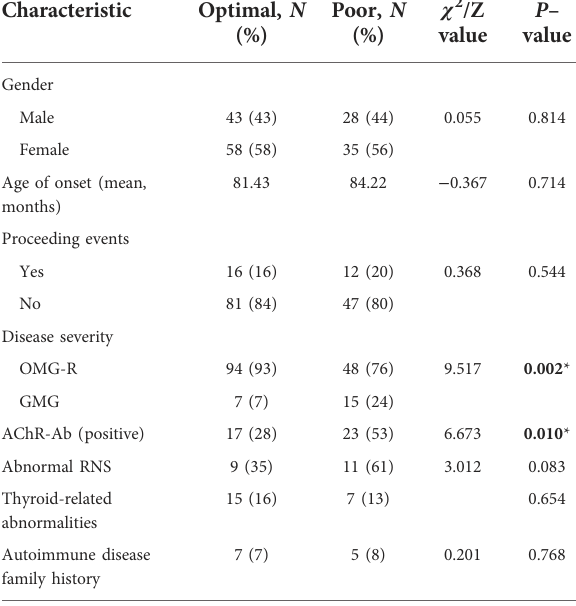
TABLE 2 Comparison of clinical characteristics between optimal and poor outcome group.